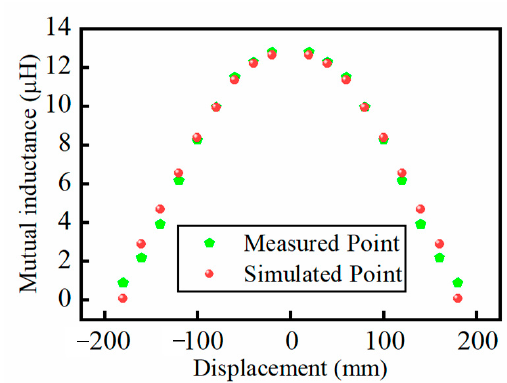
Figure 9. Comparison of measured and simulated mutual inductance.